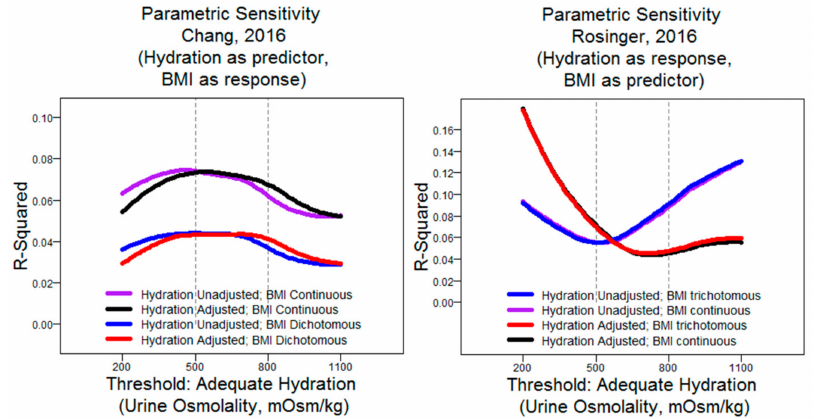
Figure 2. Model goodness (R 2 ) versus hydration threshold (via urine osmolality) in sensitivity analysis of two database studies on hydration in relation to body composition.